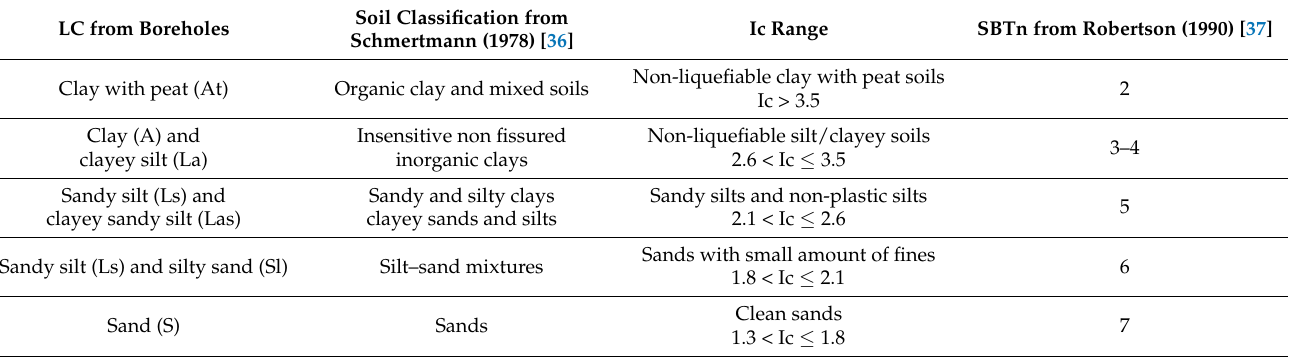
Table 1. Correspondence among the soil classification from Schmertmann (1978) [36] and SBTn from Robertson (1990) [37] and the lithological classes (LC) detected using the borehole logs.